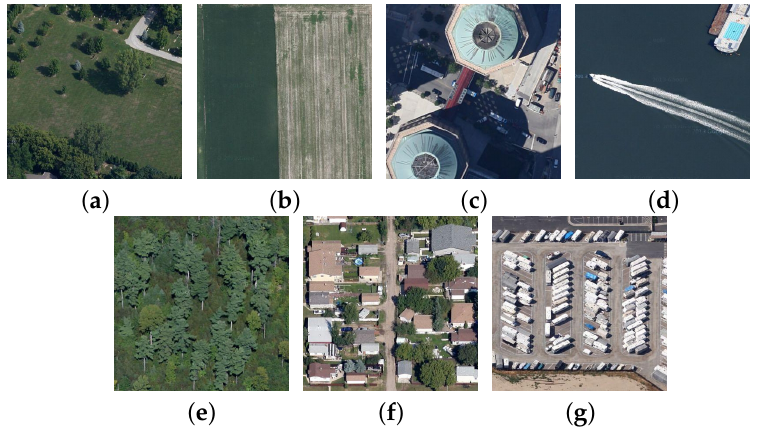
Figure 8. Example images in 7 categories in the RSSCN7 dataset. ( a – g ) Grass, field, industry, river&lake, forest, resident and parking. respectively.